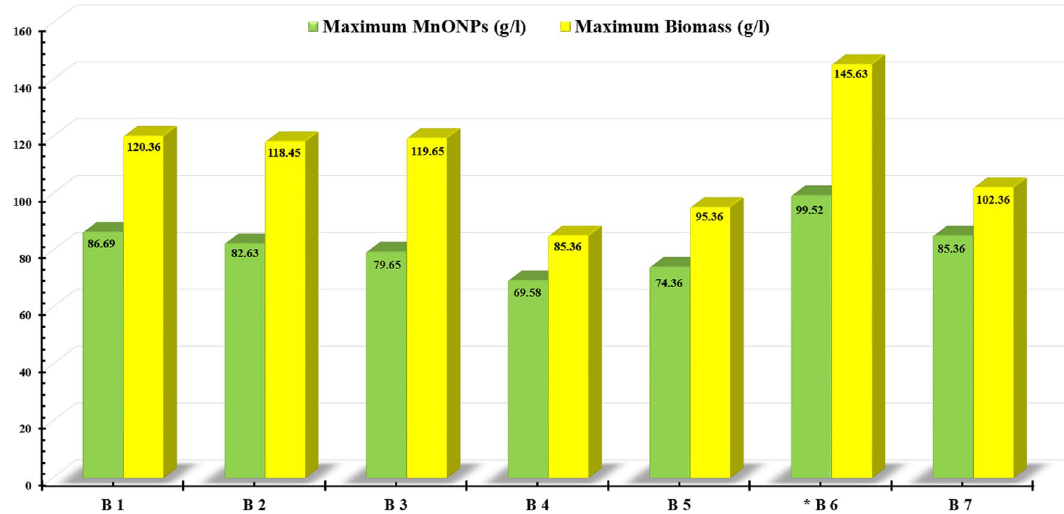
Figure 9. Effects of different aeration and agitation regimes and its timing on the growth of endophytic T.virens strain EG92 hence the fabricated MnO NPs mass weight using submerged fermentation system via batch mode within 7 L bioreactor. (B1); airflow started from 1 to 4.5 vvm/12 h and agitation started from100 to 800 rpm/6 h, (B2) airflow started from 0.5 to 2 vvm/6 h and agitation started from 100 to 800 rpm/3 h, (B3) airflow started from 1.5 to 3.5 vvm/12 h and agitation started from 50 to 250 rpm/6 h, (B4) airflow started from 0.5 to 2.5 vvm/6 h and agitation constant at 400 rpm, (B5) airflow constant at 2 vvm/12 h and agitation started from